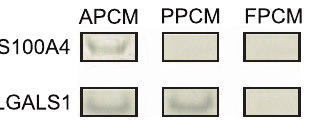
Figure 8. Western blot gels for AP, PP and FP cell culture medium (CM). The results using cultured medium not only further confirmed the results using cells and tissues (Figure 7, only expressed in AP and PP, but not in FP), but also showed that S100A4 and LGALS1 were the secreted molecules. AP, antlerogenic periosteum; PP, pedicle periosteum; and FP, facial periosteum.